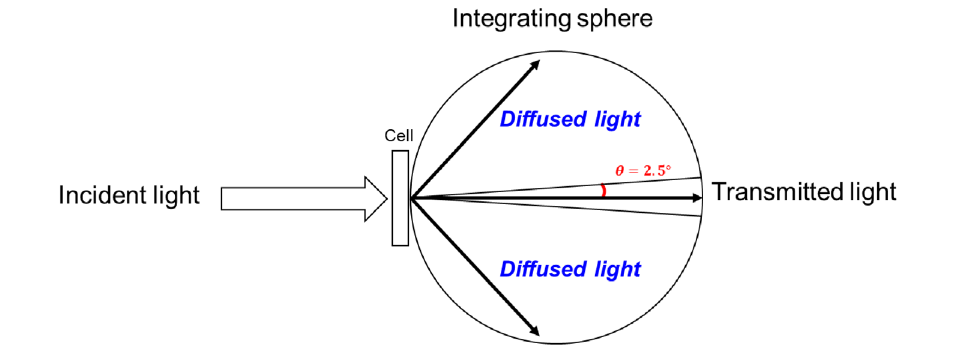
Figure 3. Calculating condition for the grating cells haze